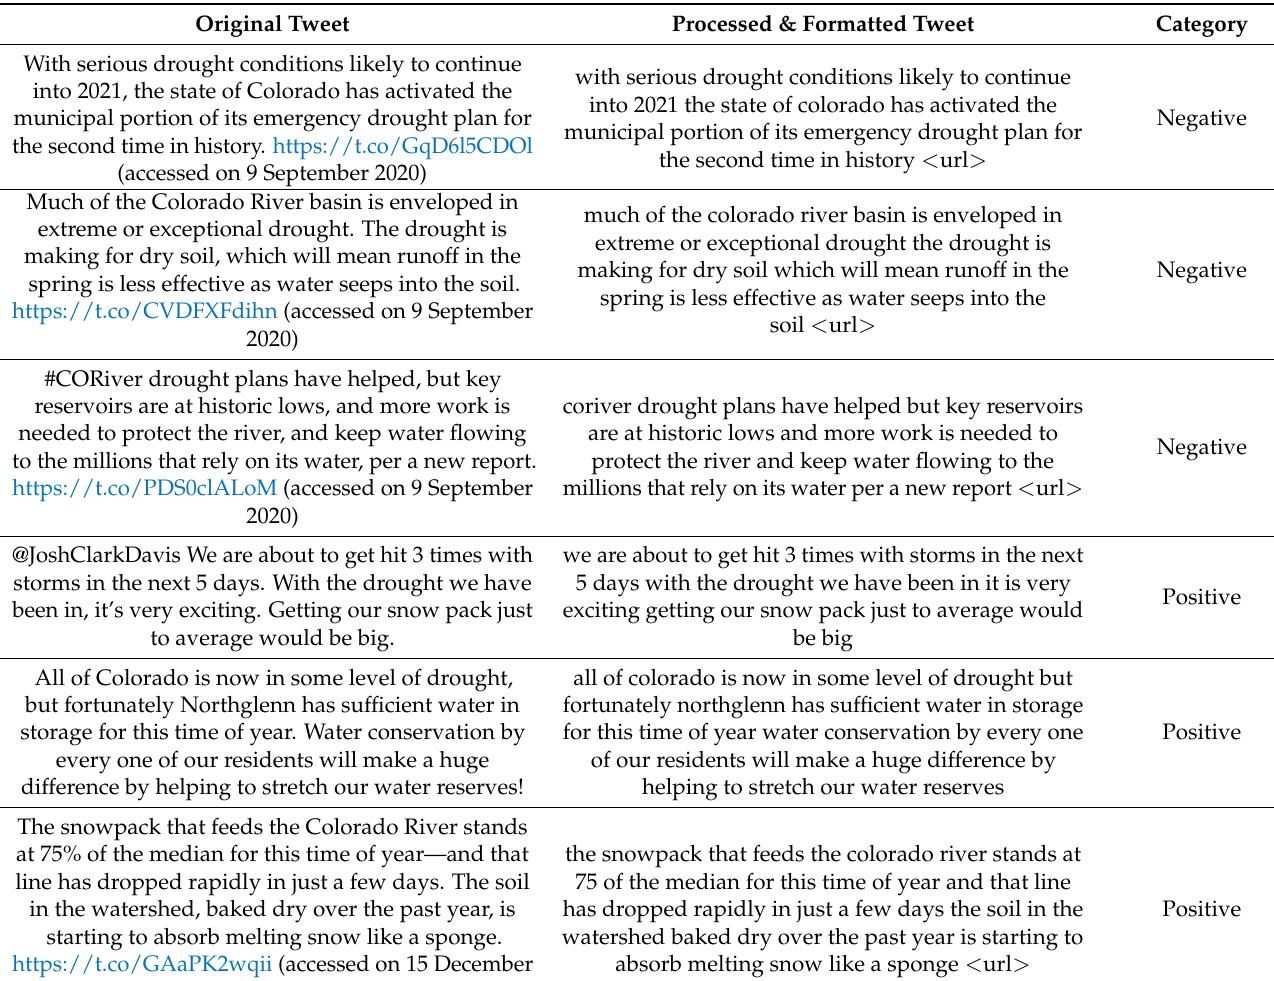
Table 5. Sample positive and negative tweets referring to